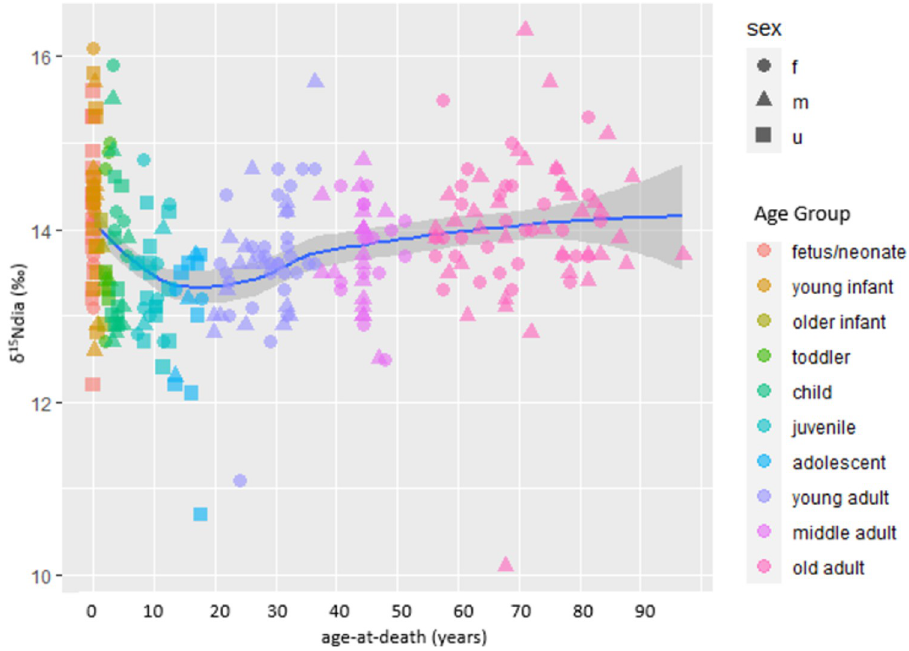
young infant mean (14.3‰) is only 0.2‰ higher and not statistically different than the fetal/ neonate mean (14.3‰; t = 0.732, p = 0.468) and only 0.6‰ higher than the mean of the Fs of reproductive age (13.7‰); this latter difference is statistically significant (t = 3.227, p = 0.002; the fetal-neonate and reproductively-aged F means also differ significantly, t = 2.711; p = 0.008). By 1 year-of-age δ 15 N values means have dropped such that sample-wide interpre- tations suggest the absence of breastfeeding although individually-based interpretations show a few individuals with isotopic patterning that could be consistent with continued breastmilk consumption (but other factors could be the cause). The older infants and toddlers have rather small δ 15 N spreads (1.3 and 2.4‰, respectively) which is likely in part related to the smaller